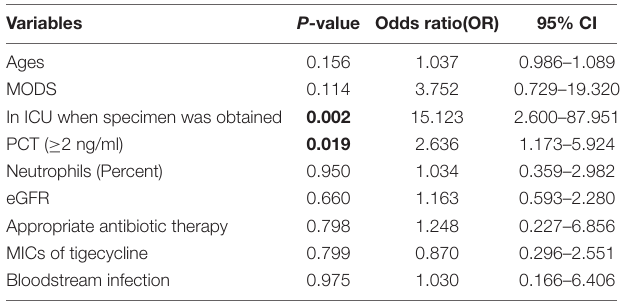
TABLE 5 | Risk factors associated with treatment failure of patients with carbapenem-resistant Acinetobacter baumannii infection.